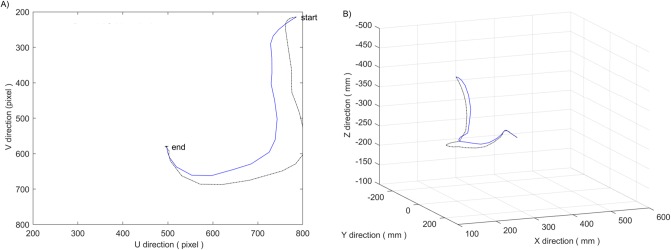
Results of introducing visual field constraints.(A) Motion trajectory in image space. (B) Motion trajectory in Cartesian space. Where the simulation result of potential field method is designated with a blue solid line, and the simulation result of image moment method is designated with a black dash-dotted line.